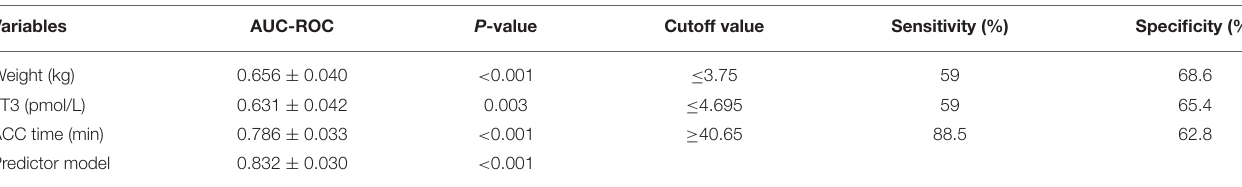
TABLE 4 | Area under the curve of variables and values to predict postoperative LCOS.